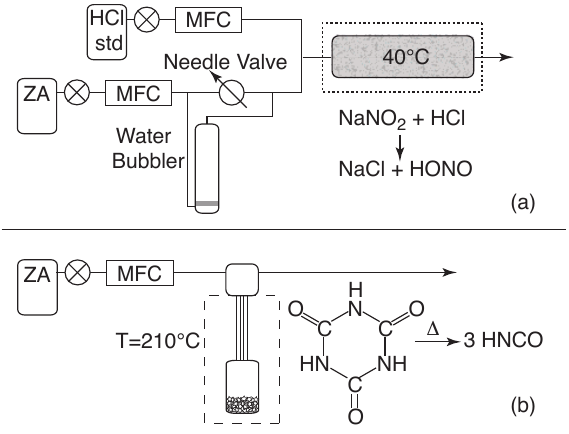
Fig. 2. Systems used to produce dilute streams of HCl and HNO 2 (a) , and HNCO (b) for the calibration of the NI-PT-CIMS